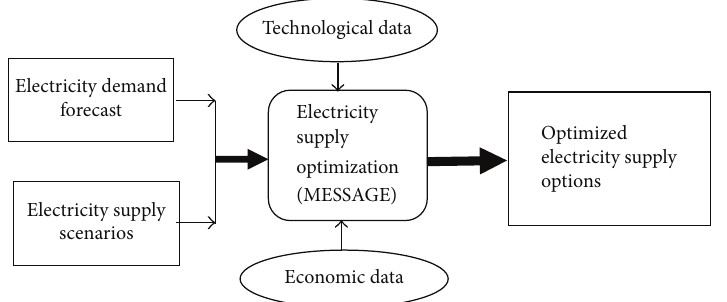
Figure 1: Conceptual modelling framework.